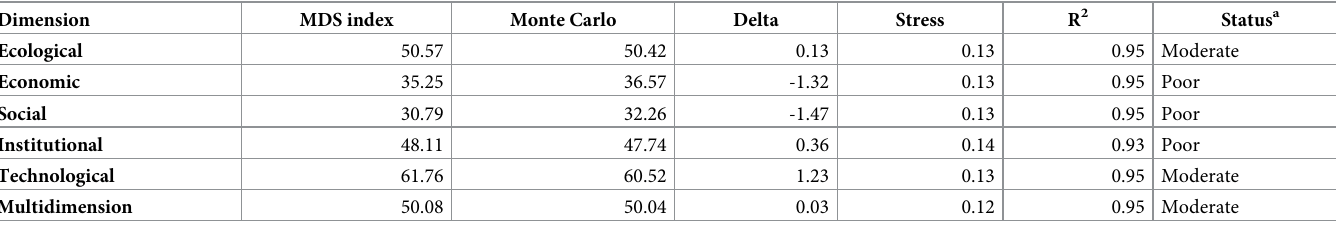
Table 2. Statistical parameter, index, and sustainability status of rice production increase per dimension in Bandung